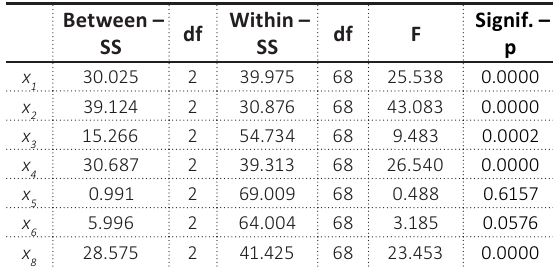
Table 5. The primary classification